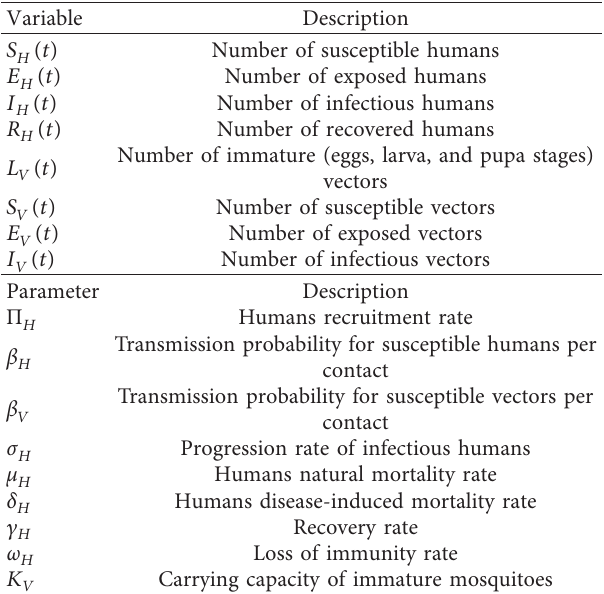
Table 1: Description of the variables and parameters of the malaria model